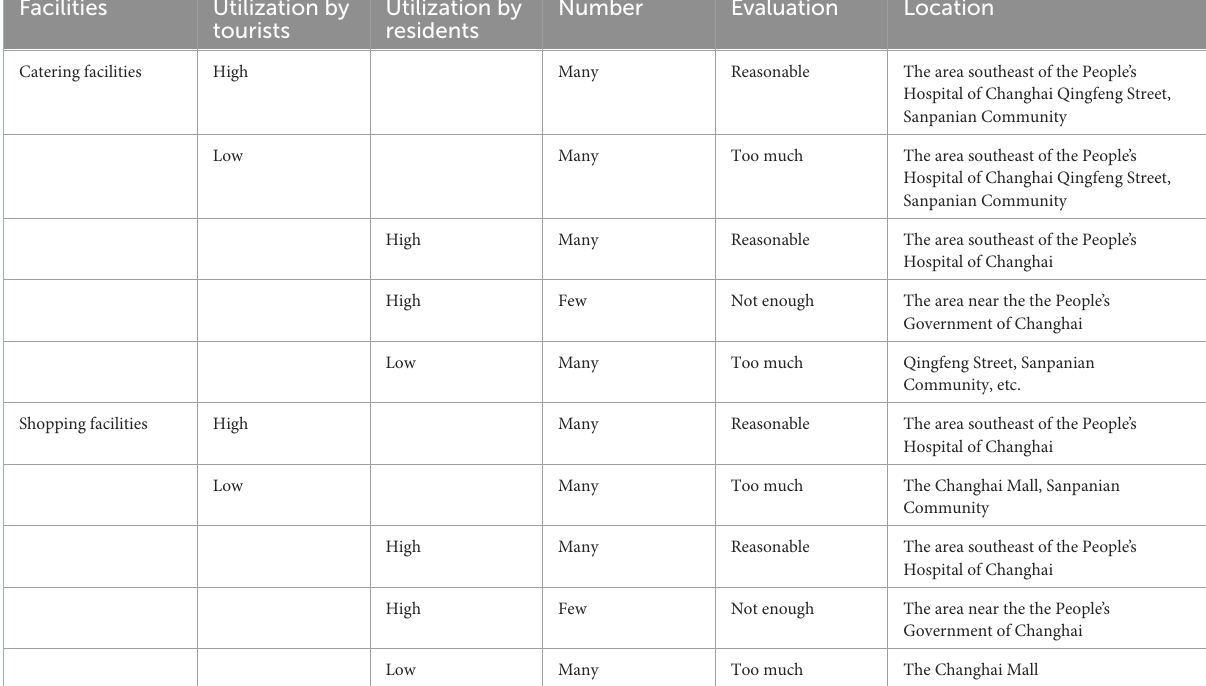
TABLE 1 Facility configuration in the study